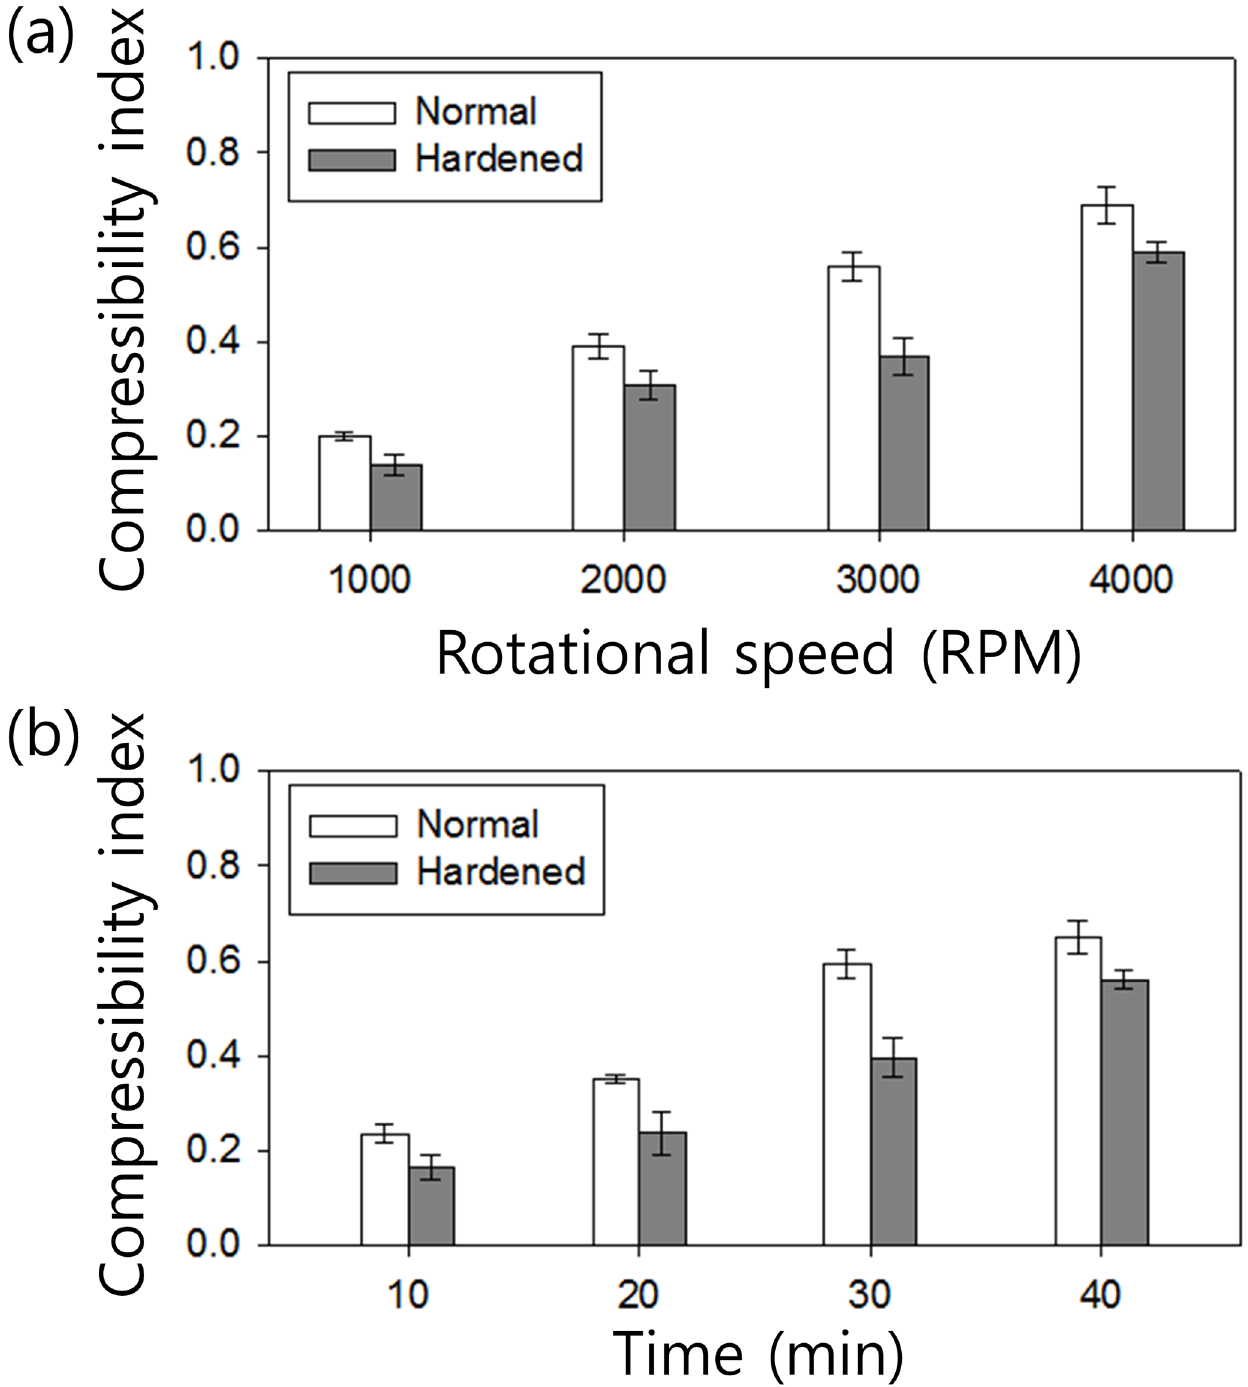
Fig 3. Determination of the rotational conditions for measuring RBC deformability. Compressibility index of normal and hardened RBCs (a) at various rotational speeds after 25 min and (b) depending on various rotation times with a fixed rotational speed at of 3000 rpm. The standard deviation shows the measured values from ten different measurements (n =